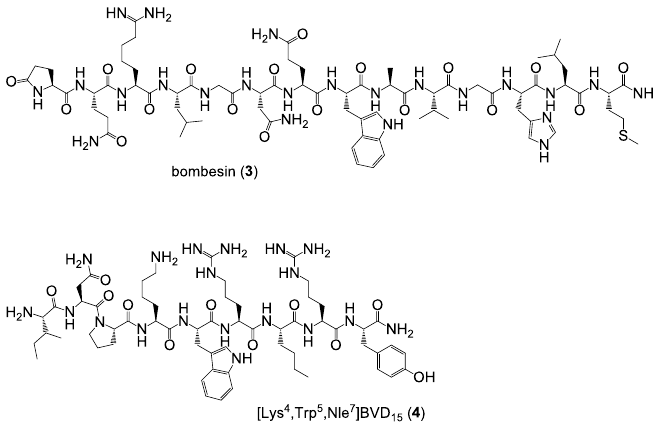
Figure 4. Depiction of the chemical structures of bombesin ( 3 ) and [Lys 4 ,Trp 5 ,Nle 7 ]BVD 15 ( 4 ) used as receptor blocking substances during the in vitro tumor cell uptake studies.